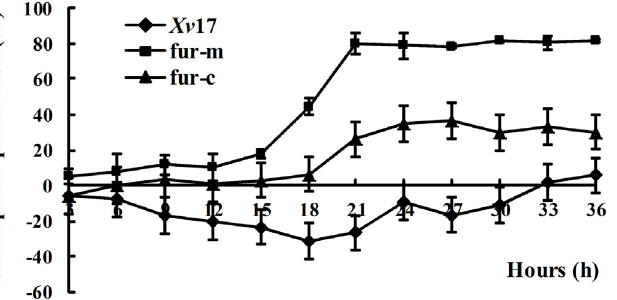
Fig 2. Quantitative comparison of siderophore production in Xv strains. Black diamond: wild-type strain Xv 17; black square: fur mutation strain fur-m; and black triangle: fur complementation strain fur-c.